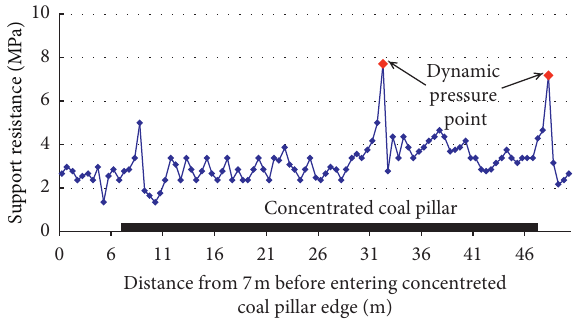
Figure 9: The variance curve of the support